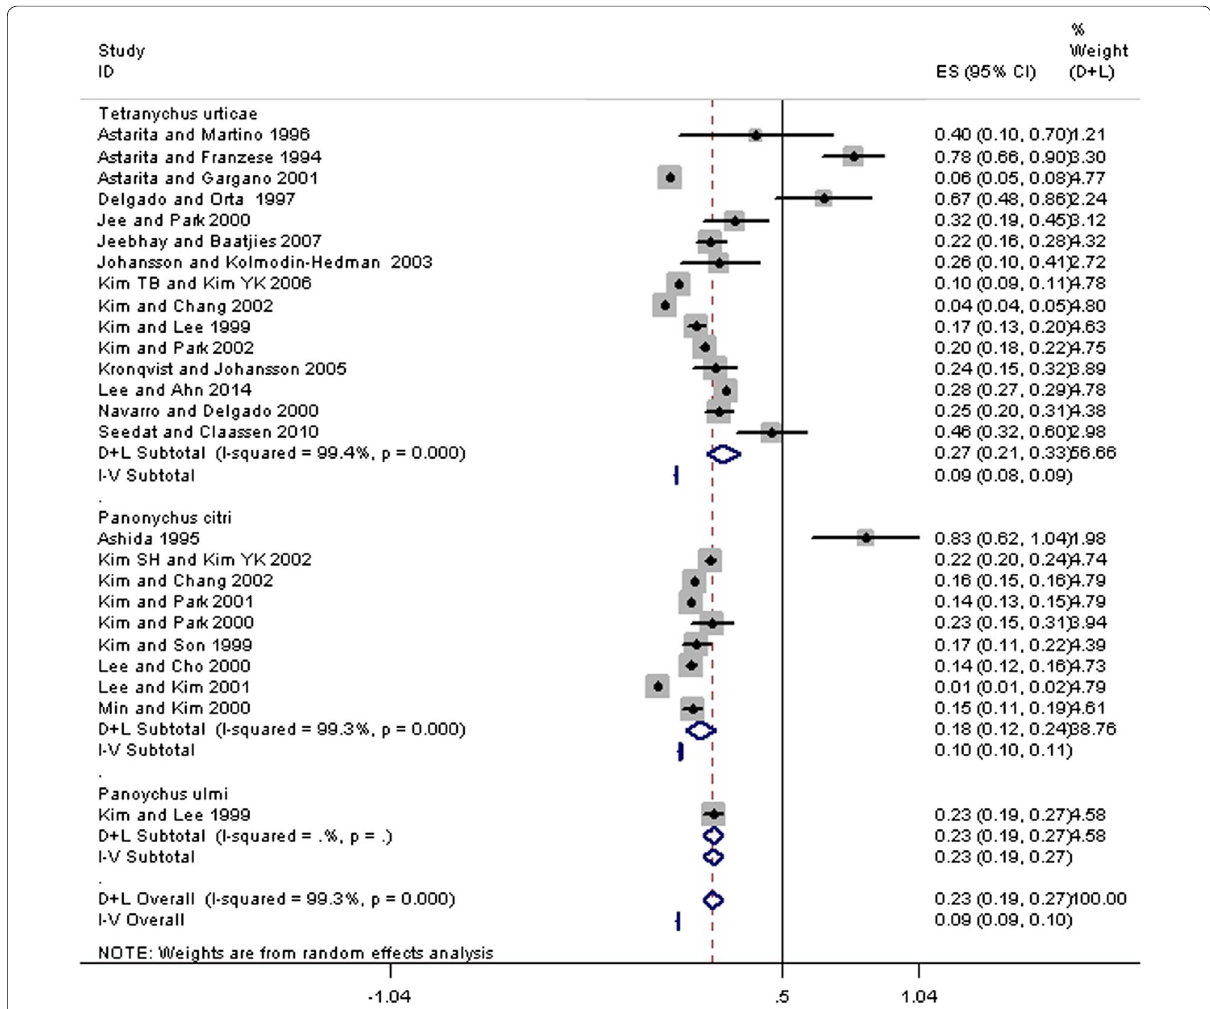
Fig. 2 Forest plot of prevalence estimates of spider mite sensitization from included studies